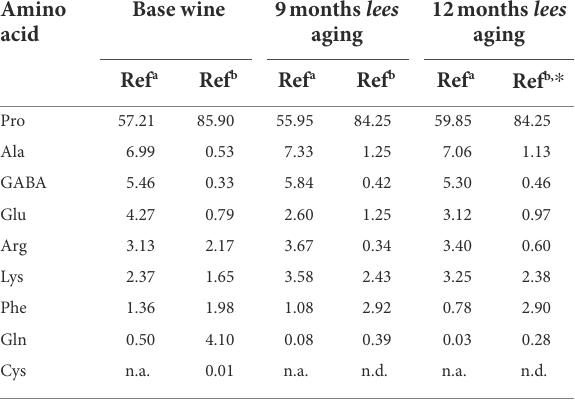
TABLE 2 Major free amino acids (% composition) reported in base wines and corresponding traditional method sparkling wines during 9- and 12-months of aging on